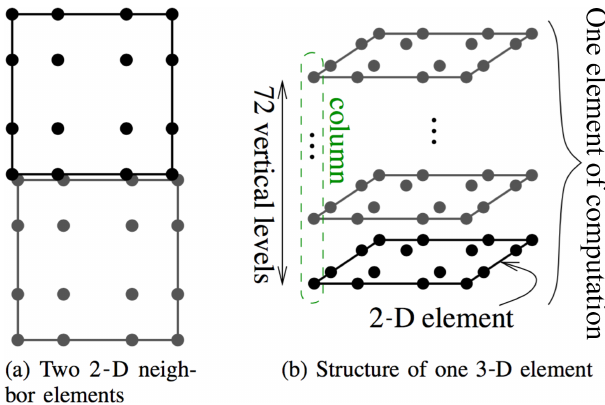
Figure 1. Horizontal (a) and vertical (b) structure of DOFs (marked with dots) in HOMME. In (a) , DOFs along the edges of 2-D ele- ments are duplicated on each element. In (b) , a 3-D element consists of a stack of 72 2-D elements, each with 16 GLL